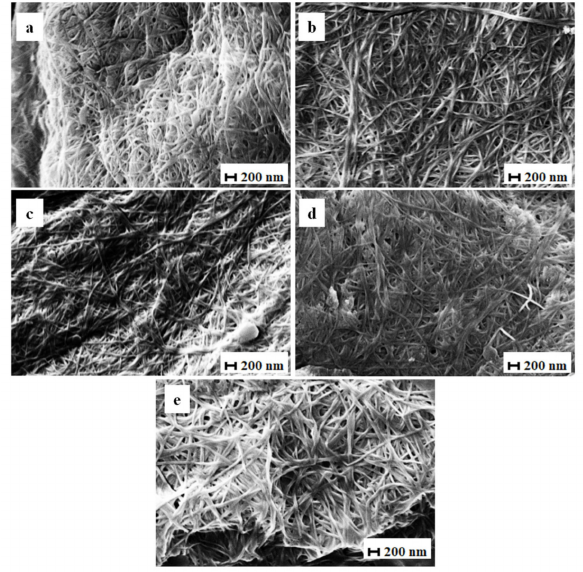
Figure 8. SEM images of moist BC. ( a )—i1d6; ( b )—i5d6; ( c )—i1d18; ( d )—i5d18; ( e )—i3d12; i—inoculum, d—harvest day; the number following “i” stands for inoculum volume 1, 3, 5 mL and the number following “d” represents the harvest day 6, 12, 18 days (electron high tension (EHT) = 10.00 kV; magnitude (Mag) = 10.00 KX; working distance (WD) = 7.0 mm; Signal A = SE1). The fiber diameter of BCd ranged, on average, between 51.34 ± 6.99 and 41.40 ± 3.87 nm (Table 2), which is consistent with previous studies. Pourjavaher, Almasi, Meshkini, Pirsa, and Parandi [72] reported a fiber diameter around 45–70 nm, while Volova et al. [73] obtained a range of 52 to 173 nm for dried BC (freeze-dried and oven-dried). The median fiber diameter of BCd ranged between 41.40 nm in membranes with 1 mL inoculum volume harvested on the 18th day (Figure 9c) and 51.33 nm in membranes with the same inoculum volume but harvested on the 6th day (Figures 9a and 7).